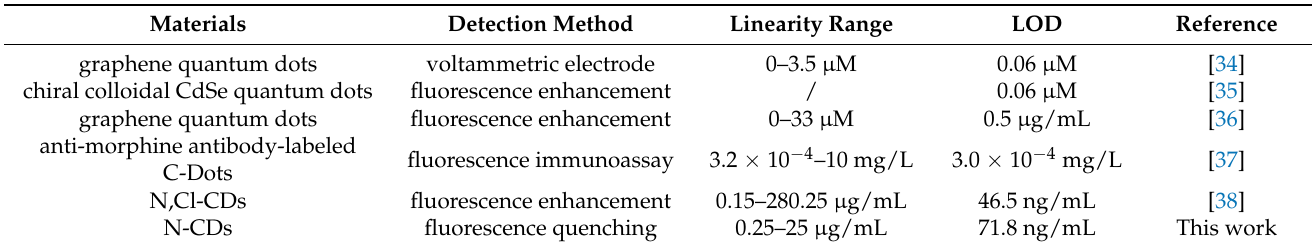
Table 2. The overview of analytical data of the reported methods for the analysis of MOR.